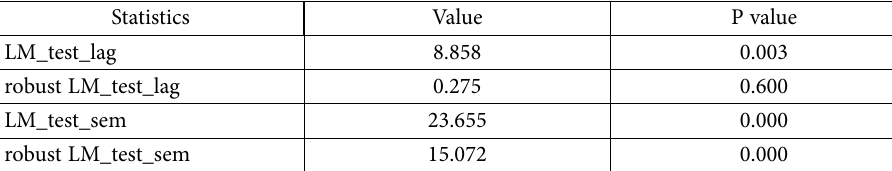
Table 7. The findings of dependency test